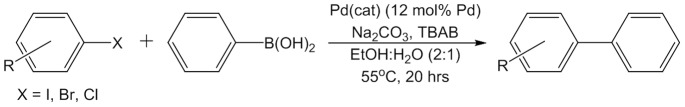
Suzuki-Miyaura C-C coupling reaction of arylhalide with phenylboronic acid.